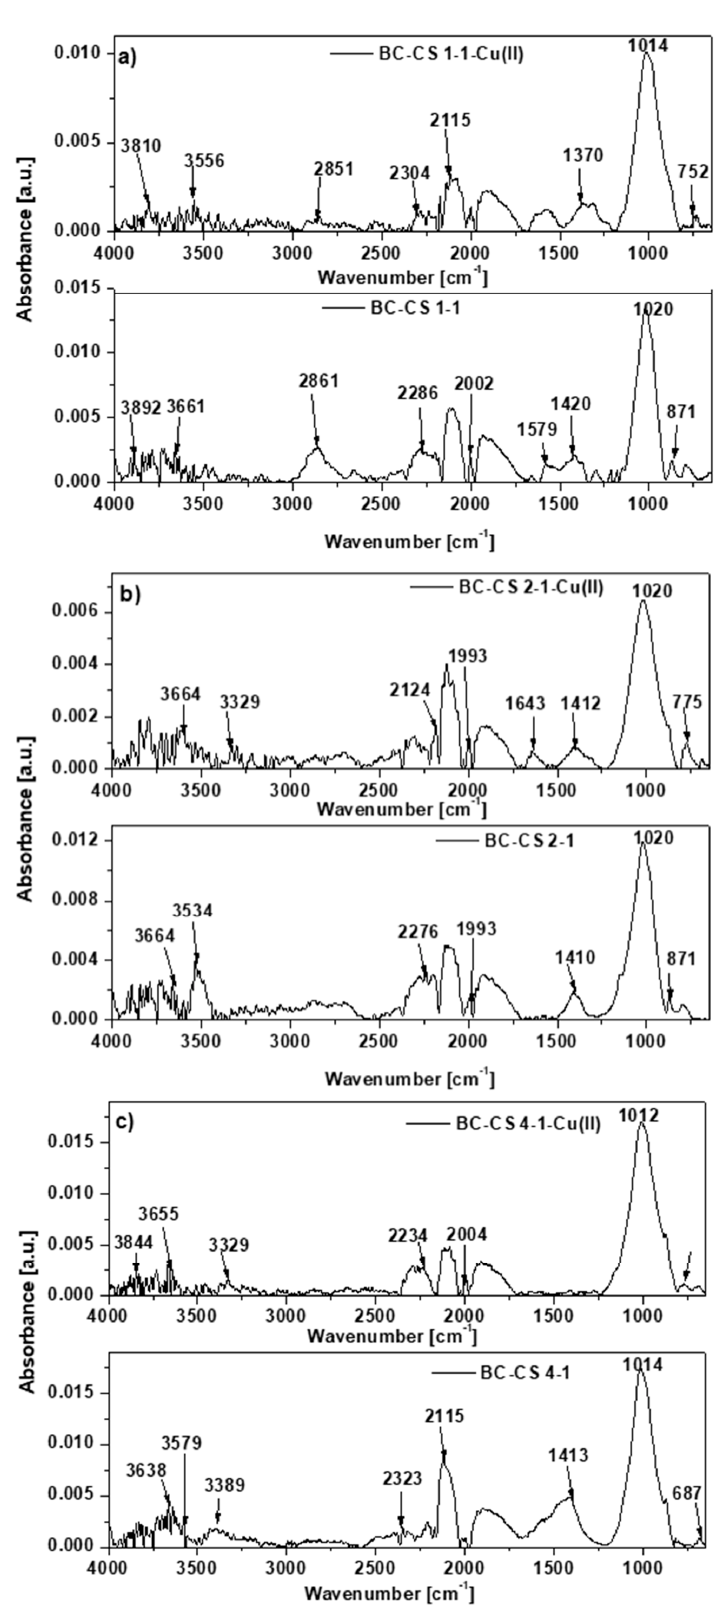
Figure 6. ATR–FTIR spectra of ( a ) BC-CS 1–1, ( b ) BC-CS 2–1 and ( c ) BC-CS 4–1 before and after the reaction with the Cu(II) ion solution.